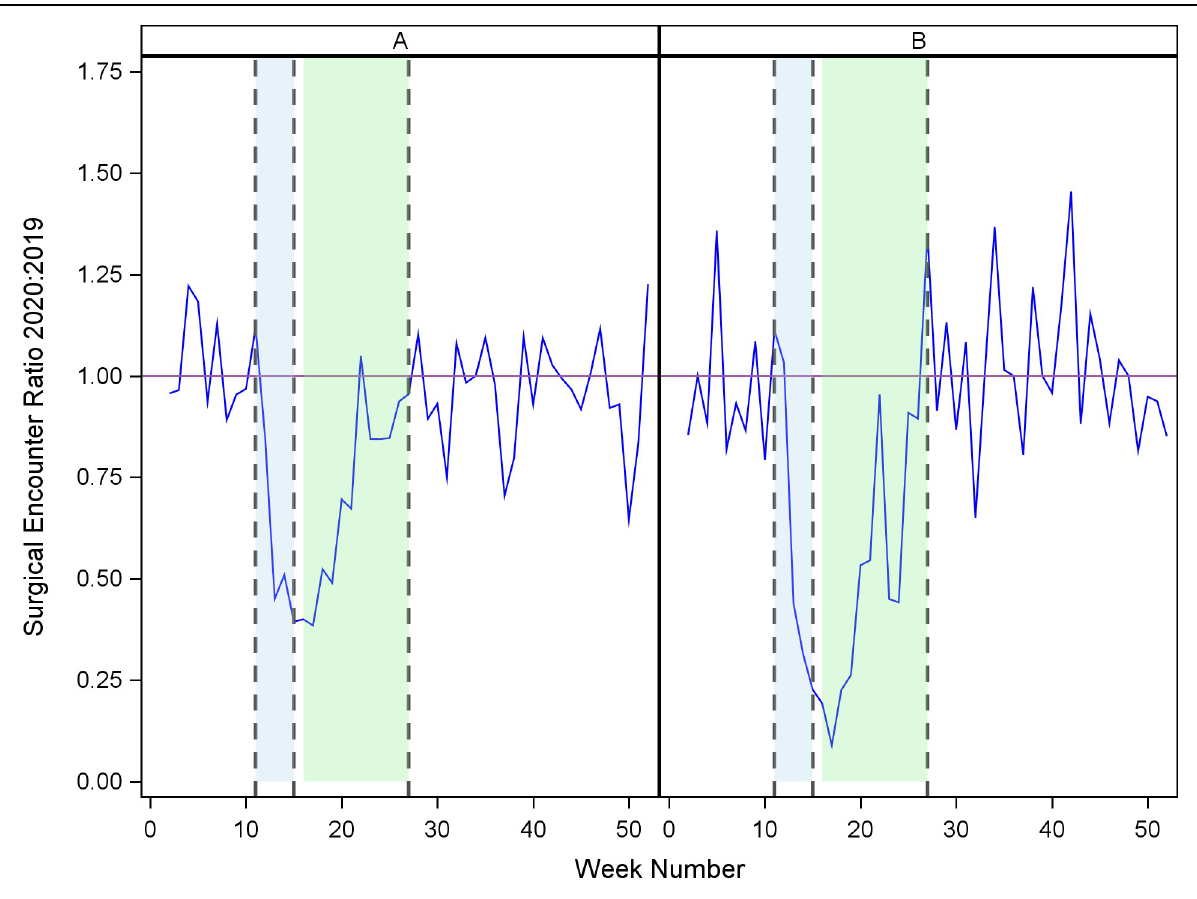
Fig 1. Weekly ratio (2020:2019) of surgical encounters, for each site. A = Allegheny Health; B = Johns Hopkins (Vertical reference lines denote periods beginning 3/8/20 (week 11), 4/5/20 (week 15), and 6/28/20 (week 27)).